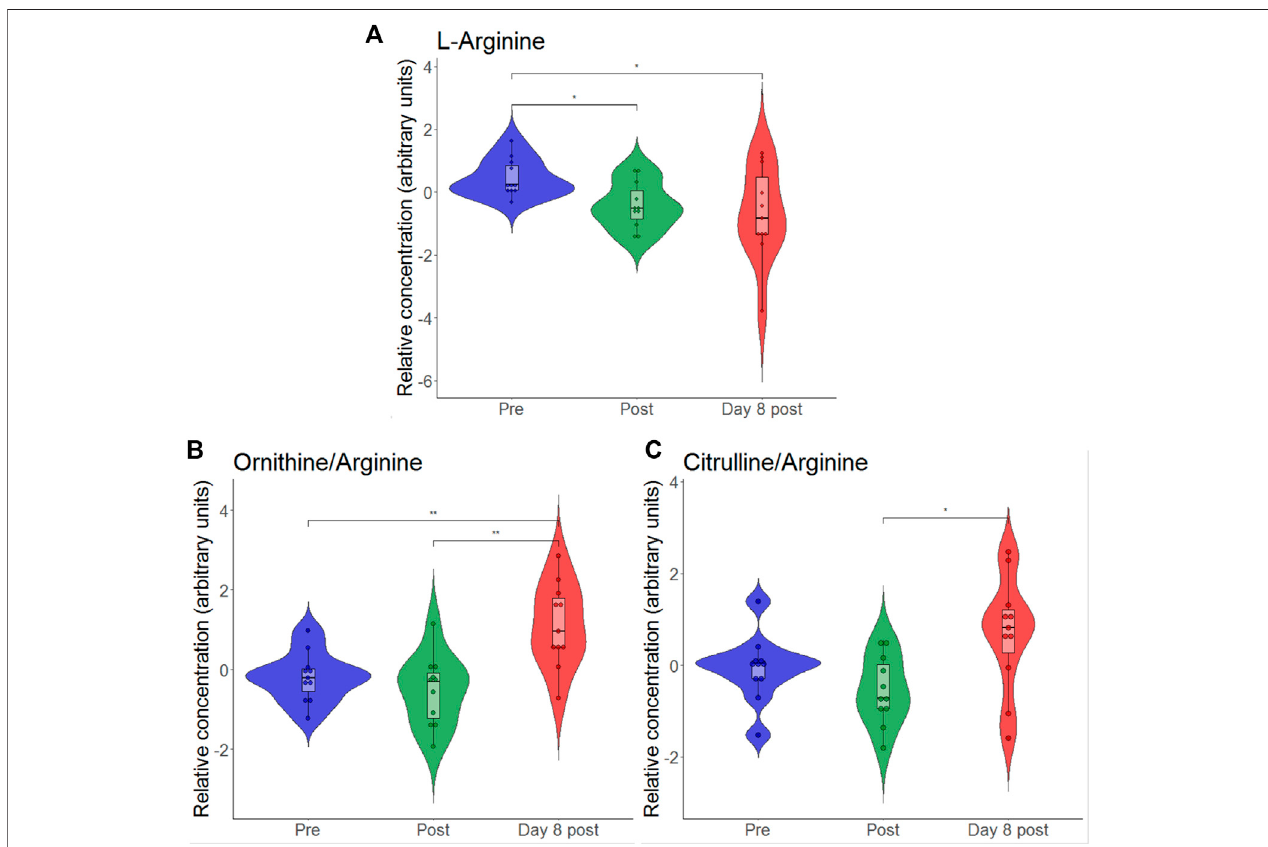
FIGURE4| Violinplotswithrelative bloodmetaboliteconcentrationsimmediately after(post)andonday8aftertheeccentricexerciseforL-arginine (A) ,theratioof ornithine-to-arginine (B) and the ratio of citrulline-to-arginine (C) . * p ≤ 0.05, * p ≤ 0.01.